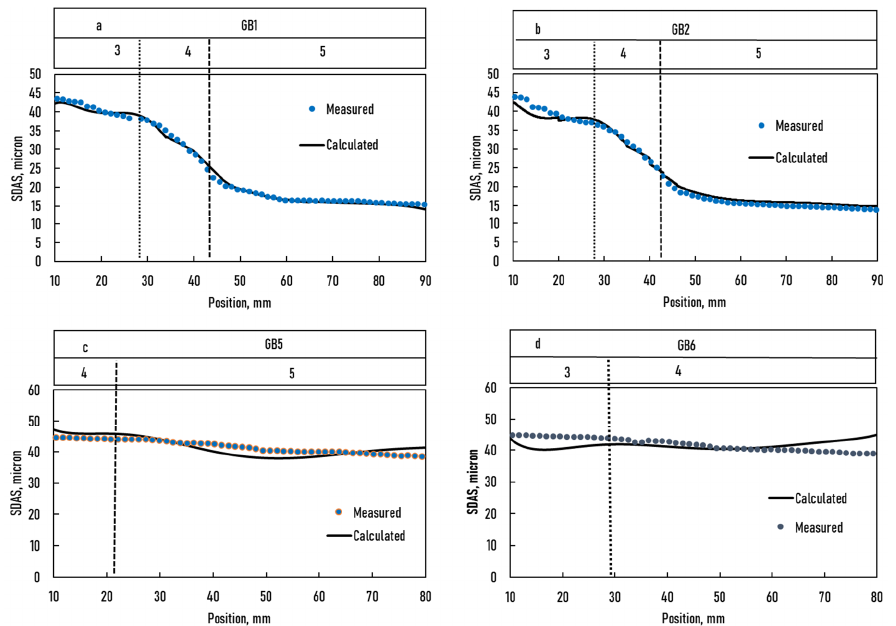
Figure 14. Measured and calculated SDAS vs. position in the sample: ( a ): GB1, ( b ): GB2, ( c ): GB5, ( d ): GB6.